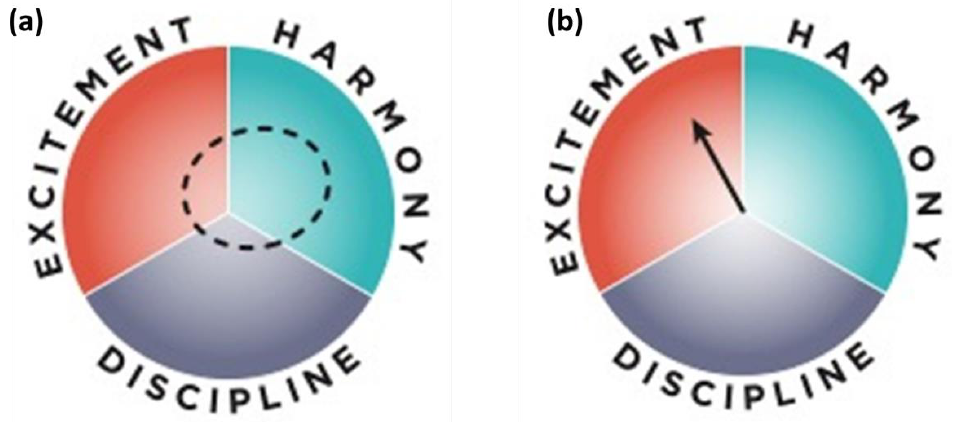
Figure 19. Comparing the wish spot ( a ) with the actual compass reading ( b ).